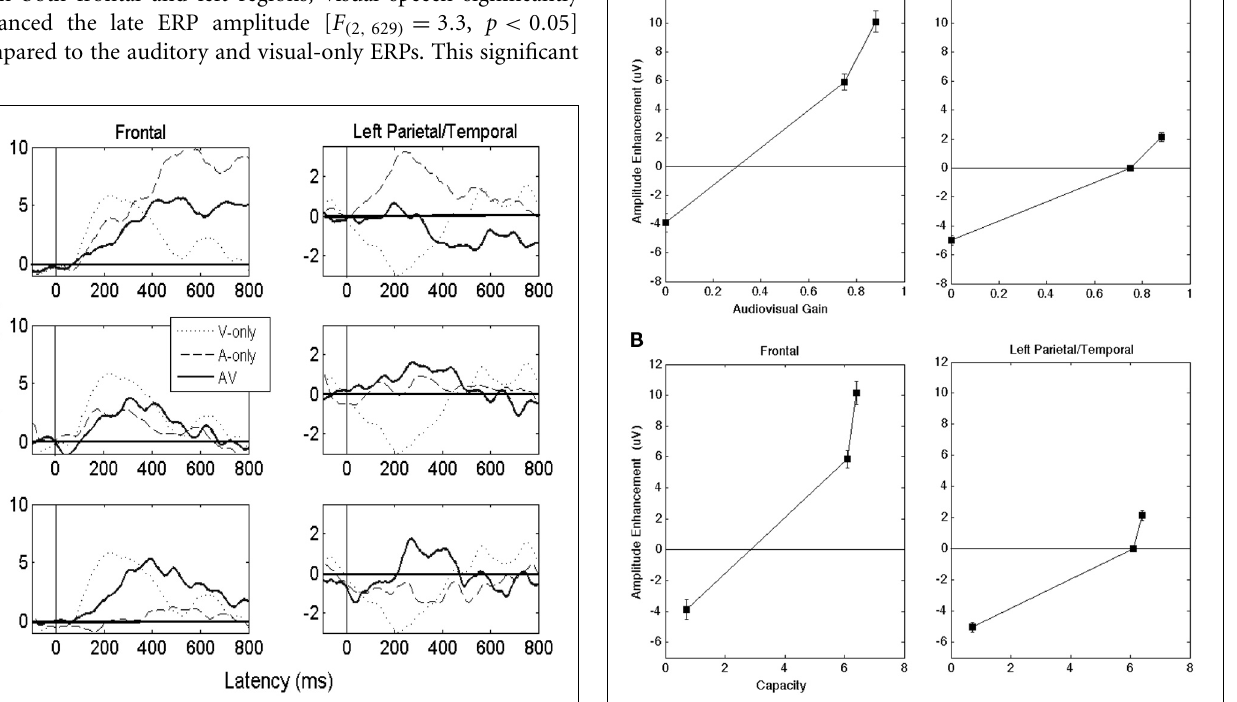
FIGURE 3 | Figure displaying averaged ERPs obtained from the “clear” auditory condition (top), the − 12dB S/N ratio (middle), and the − 18dB S/N ratio (bottom). The solid line shows the averaged ERPs for the audiovisual (AV) condition, and the dashed line represents the auditory-only (A) condition. The dotted line represents the visual-only (V) condition, which is strongly expressed in frontal regions due to feed-forward connections originating from occipital brain regions. Results are shown using sample electrodes from the frontal scalp region (e.g., F3, F7, and Fz), and Parietal/Temporal Region (e.g., C3, P3, and T5).